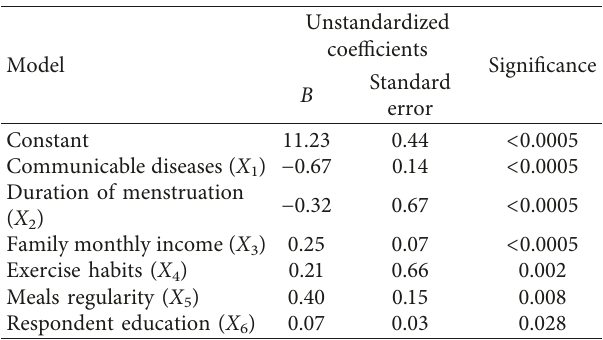
Table 5: Association of socioeconomic and environmental vari- ables with anemia severity.